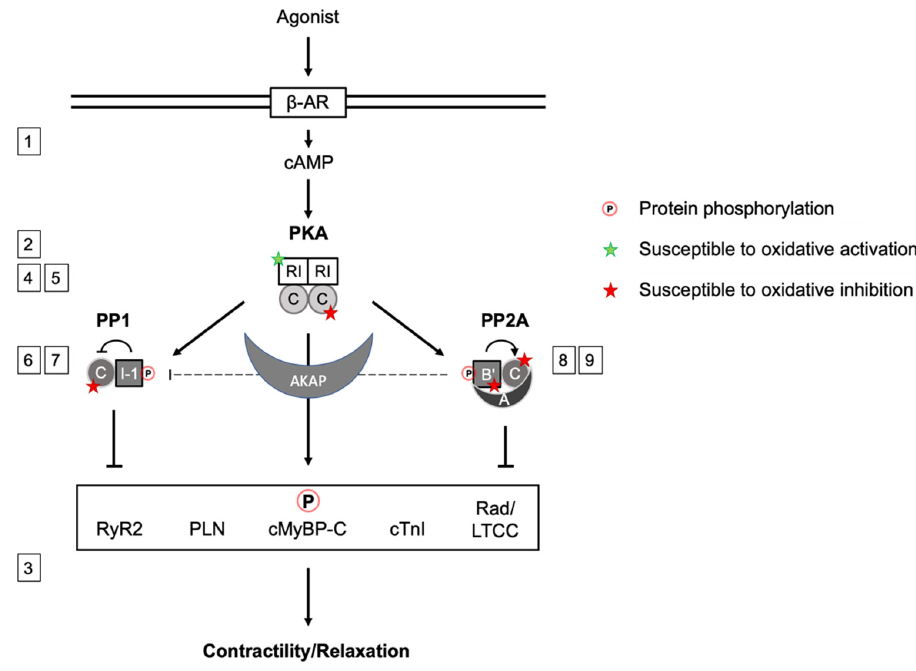
Figure 1. Scheme summarizing the signaling network between PKA, PP1 and PP2A, their interaction upon β AR stimulation and cAMP production or direct oxidative modification. PKA phosphorylates and activates inhibitor 1 (I-1), which inhibits PP1. Several B‘-PP2A regulatory subunits have been shown to be subject to phosphorylation, B56 δ is phosphorylated by PKA, enhancing PP2A activity by dissociation from the A-subunit. PP2A mediates I-1 dephosphorylation. PKA phosphorylates substrate proteins in cardiac myocytes that regulate cardiac contraction, which is counteracted by PP2A and PP1 action. In addition to the regulation by phosphorylation, signaling subunits labeled with a star are susceptible to oxidation. Green: enhanced activity, red: inhibitory effect. The scheme synergizes aspects of the regulation of PKA, PP1 and PP2A activity by phosphorylation and simultaneous oxidation to orchestrate contractility. Numbers 1–9 referring to the respective section in the manuscript.